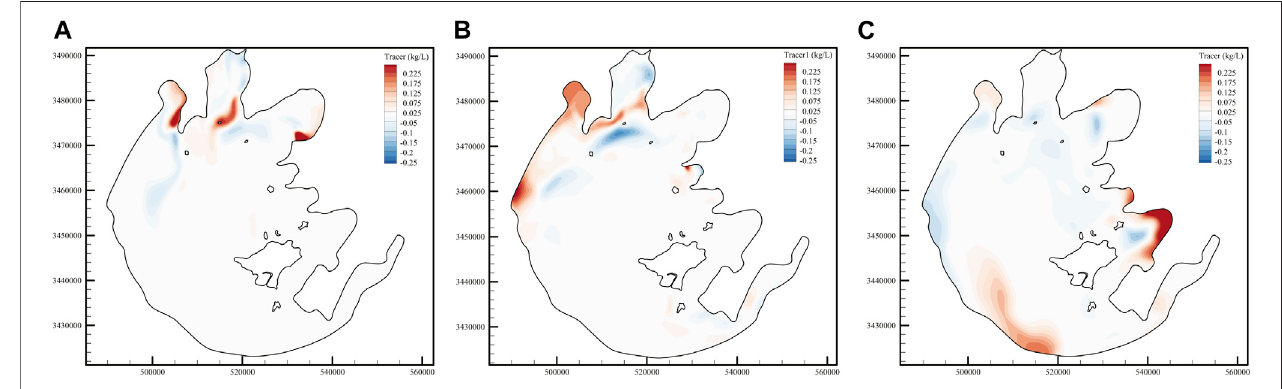
FIGURE15| Spatialin fl uenceofvegetationontracerconcentration;positivevaluesinthe fi gureindicatethatthetracerconcentrationundertheconditionofwithout vegetation is higher than that under the condition of with vegetation. (A) Jul, 31st, (B) Sept, 30th, and (C) Nov, 30th.